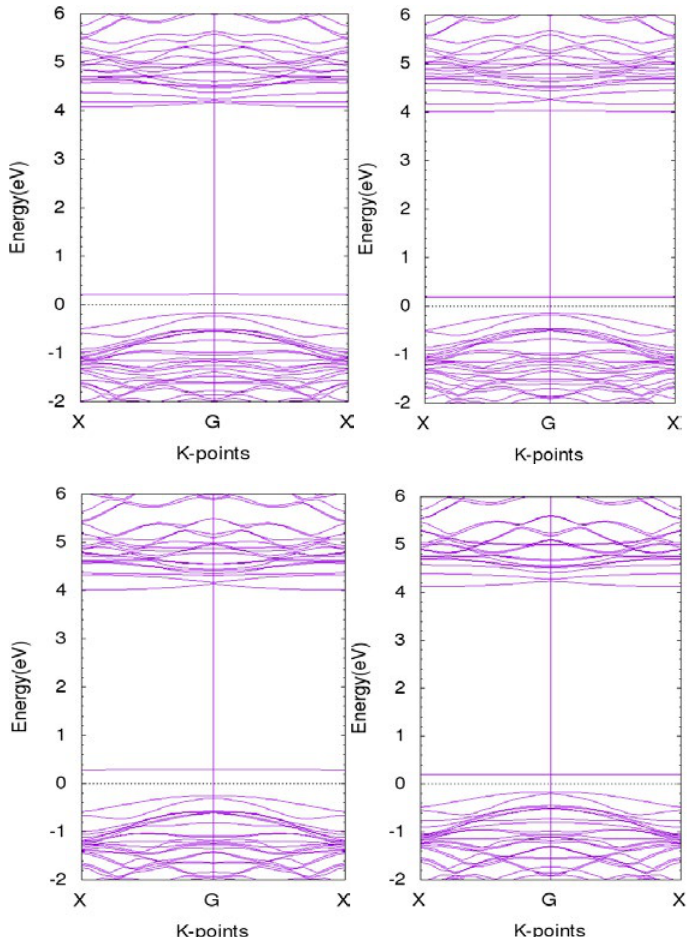
Fig. 3. Electronic band structures for the SO Figure 3. Electronic band structures for the SO 2 adsorbed and O 3 adsorbed BN nanotubes.